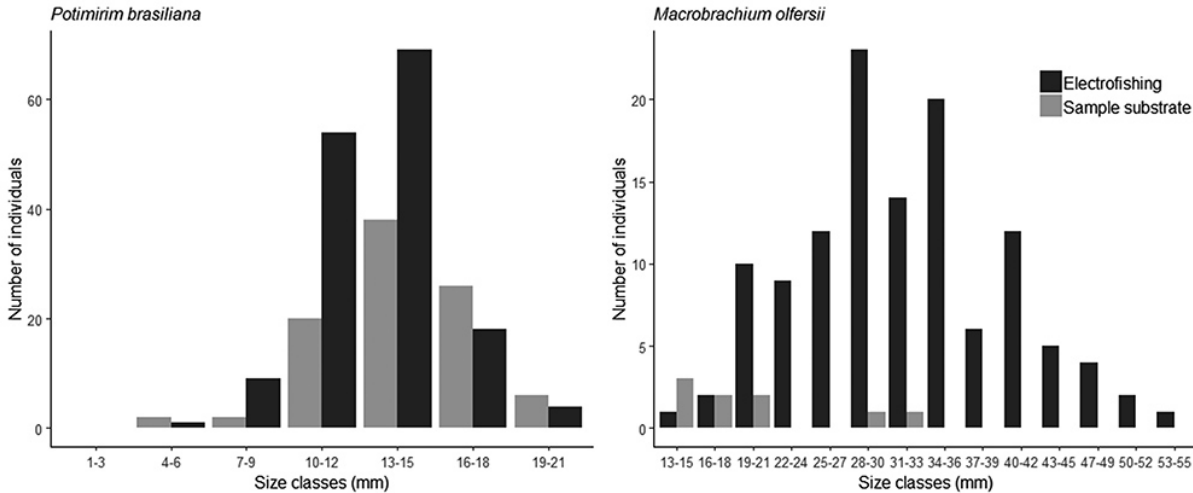
Figure 2. Size classes of Potimirim brasiliana (left) and Macrobrachium olfersii (right) in absolute number for electrofishing (dark grey) and sample substrate (light